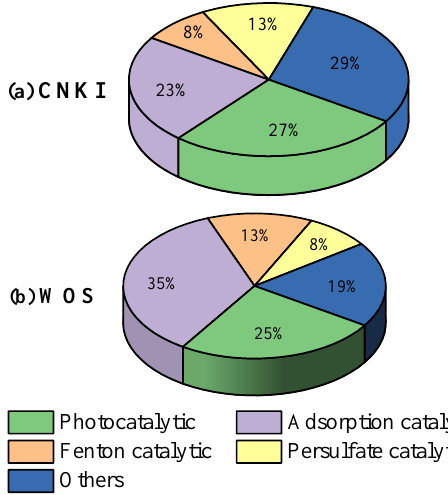
Figure 4. The percentage of various DBD collaborative catalytic methods in ( a ): CNKI; ( b ): WOS.